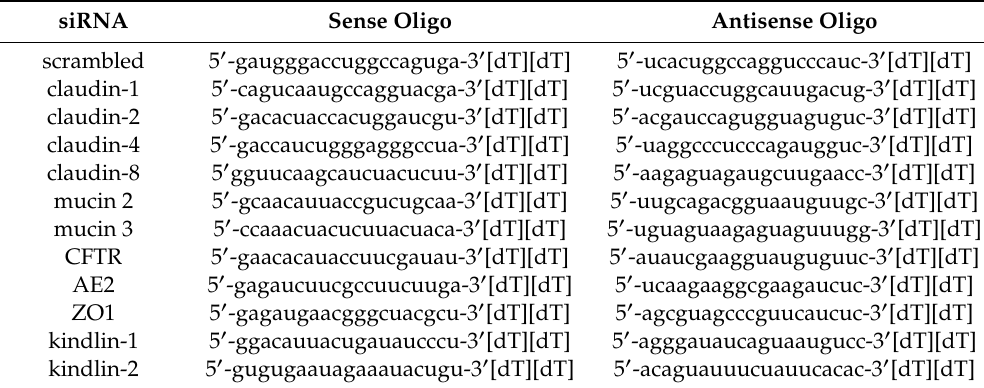
Table 1. siRNAs used in knockdown